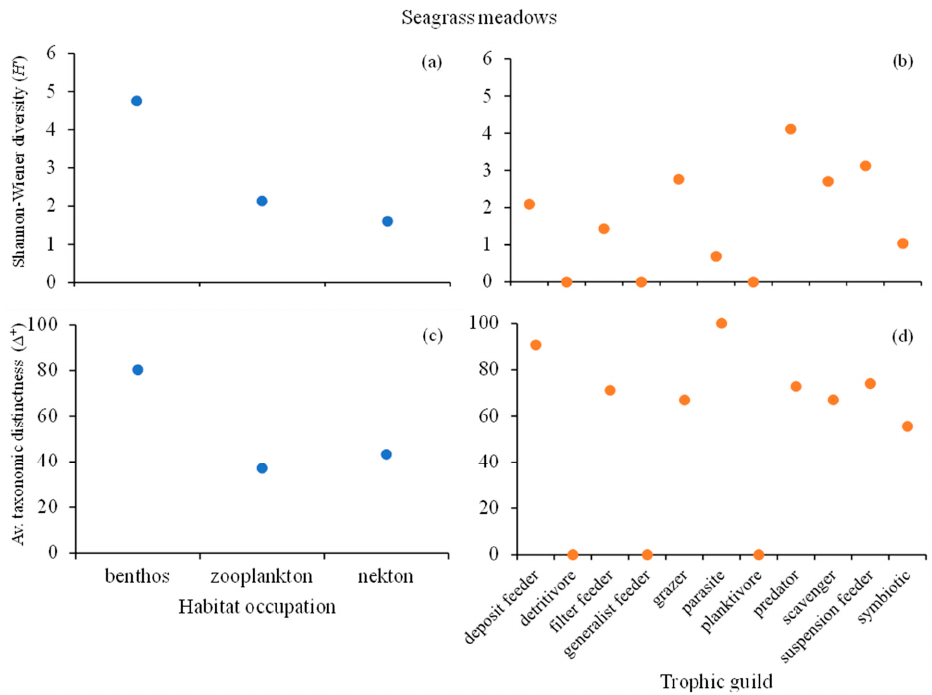
Figure 6 . Community composition of seagrass meadows in Maputo Bay. Shannon–Wiener diversity index (H’) regarding ( a ) habitat occupation (HO) and ( b ) trophic guild (TG). Average taxonomic distinctness index ( Δ +) regarding ( c ) HO and ( d ) TG. (Note: all values indicated in the graphs as 0 are due to the low number of occurrences).